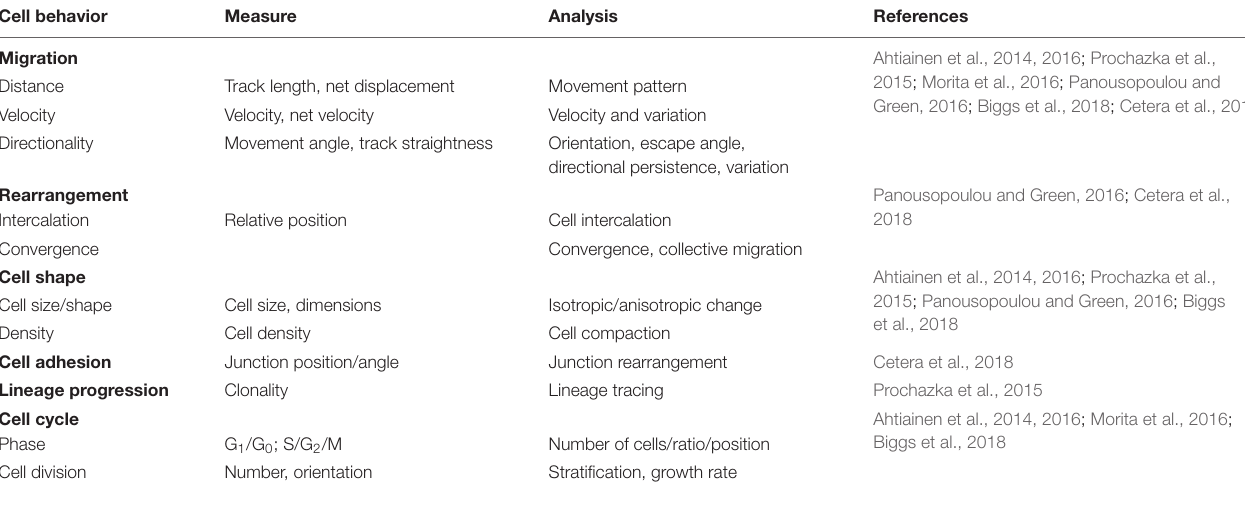
TABLE 2 | Cell behavior analyses in live tissue imaging of ectodermal